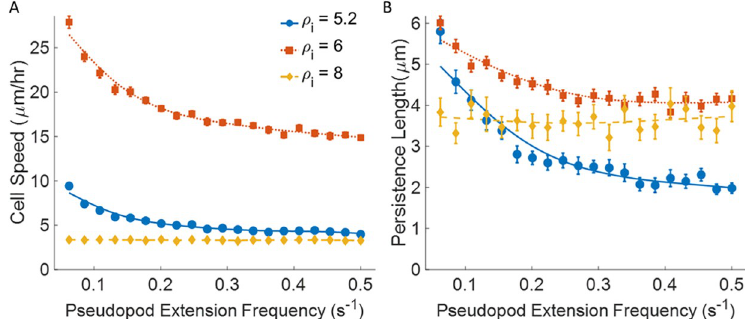
Fig 5. Effect of cell mechanoactivity. Plots for v avg , L p , μ , and α as a function of increasing cell mechanoactivity A) Cell speed B) Persistence length. C gel = 3.7 mg/ml, ρ fiber = 1.0 x 10 − 3 fibers/ μ m 3 , and AI = 0. Simulation time = 48hrs. n = 20. Dotted red lines are 5.2 motifs/monomer ( ◼ ), solid blue lines are 6 motifs/monomer ( ● ), dashed yellow lines are 8 motifs/monomer ( ◆ ). Error bars represent ± SEM.